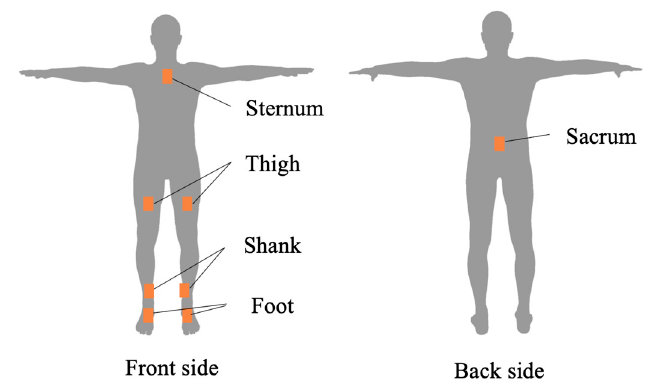
Figure 1. Placement of the inertial measurement units.